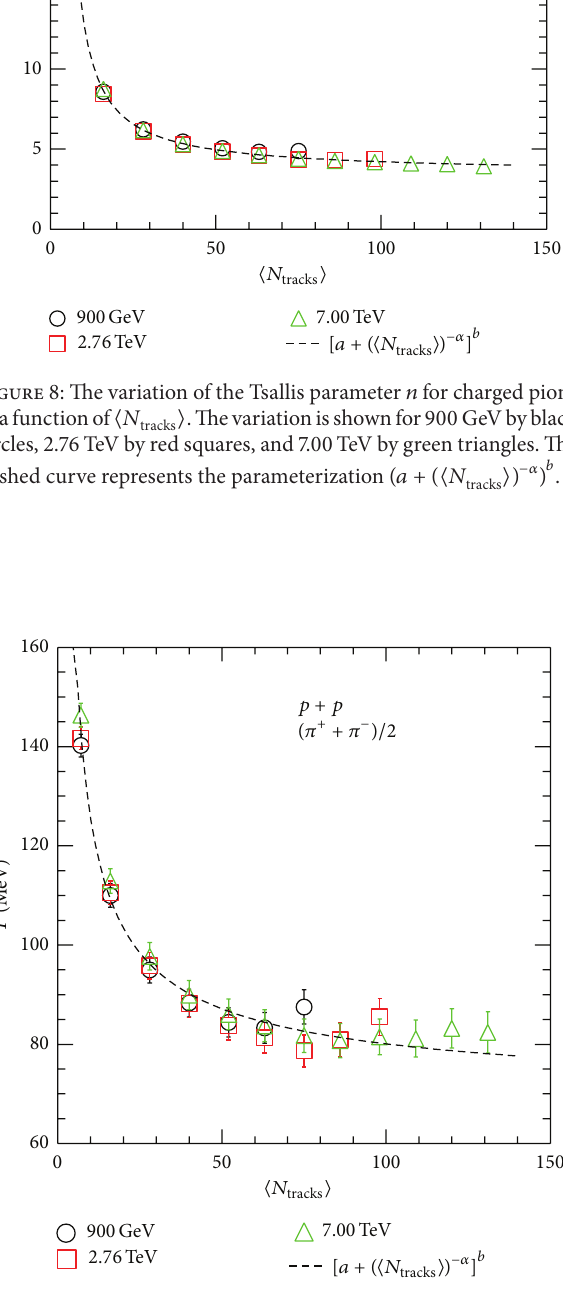
Figure 9: The variation of the Tsallis parameter 𝑇 for charged pions ⟩ .Thevariationisshownfor900 GeVbyblack asafunctionof ⟨𝑁 tracks circles, 2.76 TeV by red squares, and 7.00 TeV by green triangles. The ⟩) −𝛼 ) 𝑏 . dashed curve represents the parameterization (𝑎 + (⟨𝑁 tracks